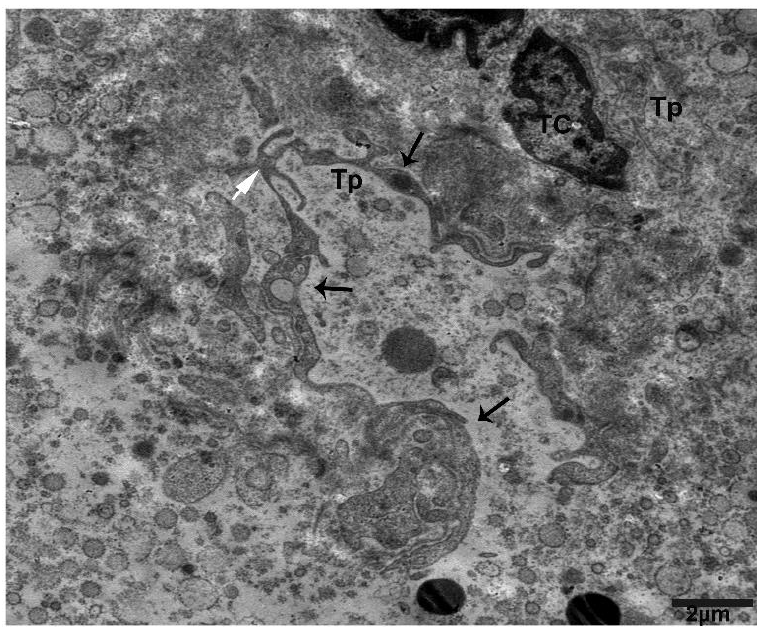
Figure 8. Numerous clusters of shade / extracellular vesicles from Tps within the connective tissue between lobules. The TC nuclei bears heterochromatin in their periphery. Within the connective tissue, there are multiplex clusters of shading / extracellular vesicles scattered around, and the podoms contain vesicle and mitochondria (black arrows), forming trajectories from the podomic area (white arrow). Scale bar = 2 µ